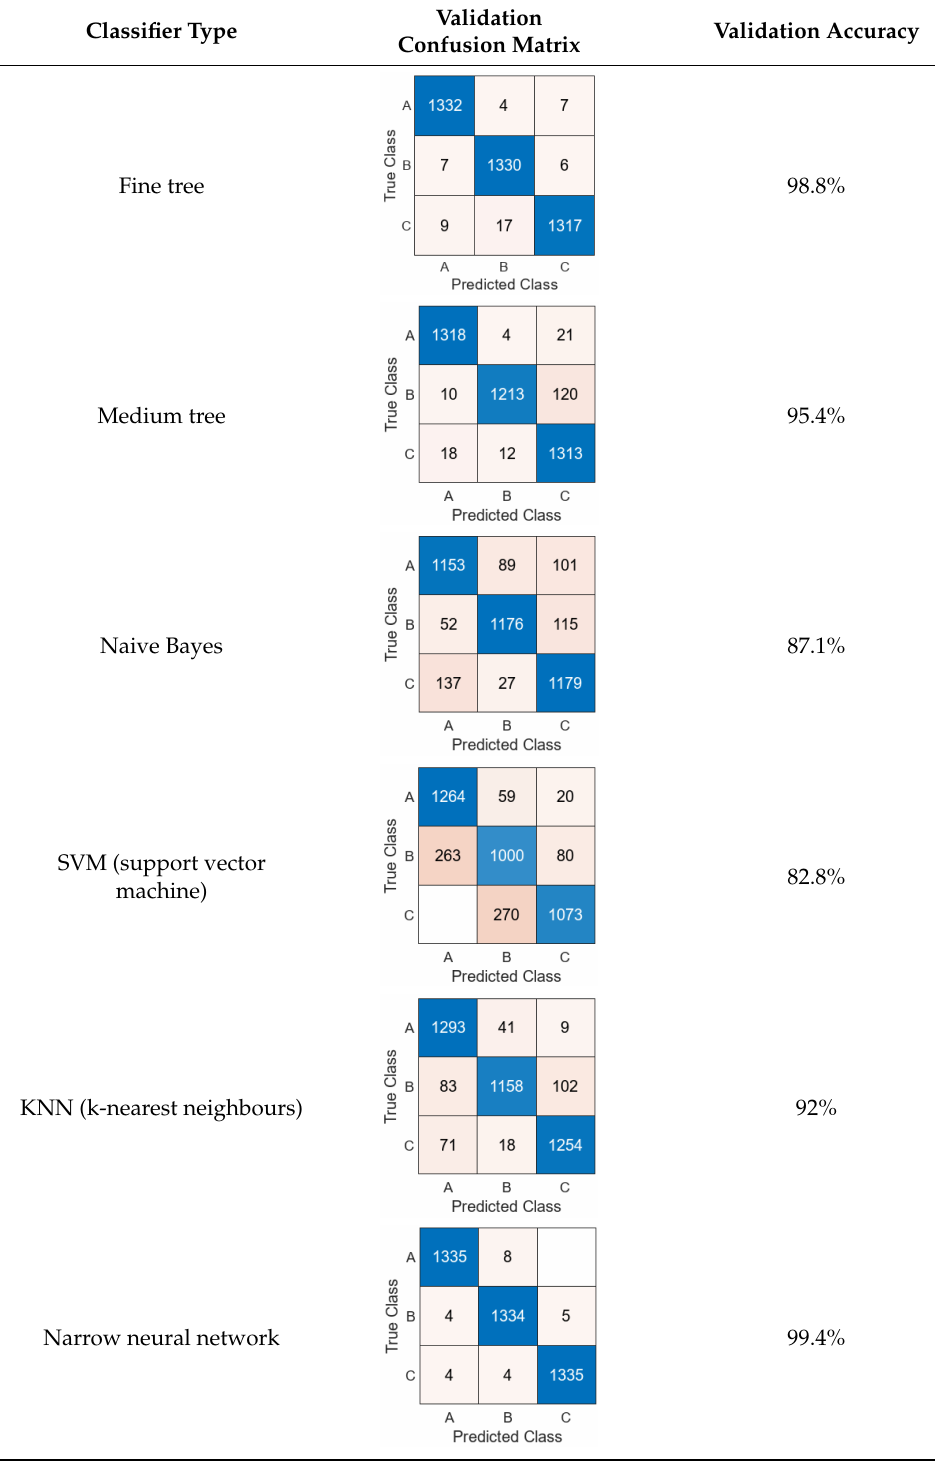
Table 1. Reference localisation